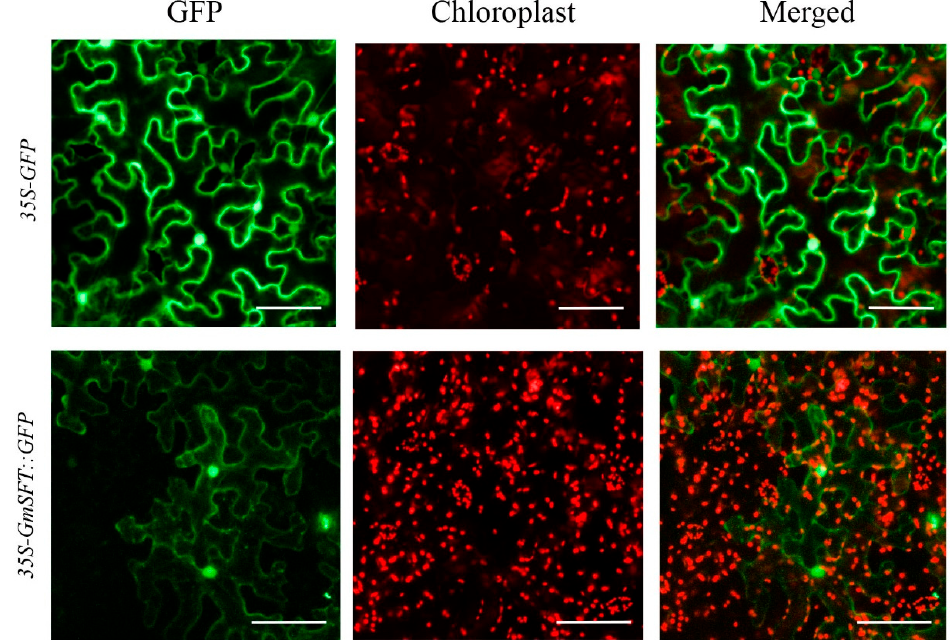
Figure 9. Diagram showing subcellular localization of GmSFT gene in the leaf of N. benthamiana . Bar indicates 50 μ m.